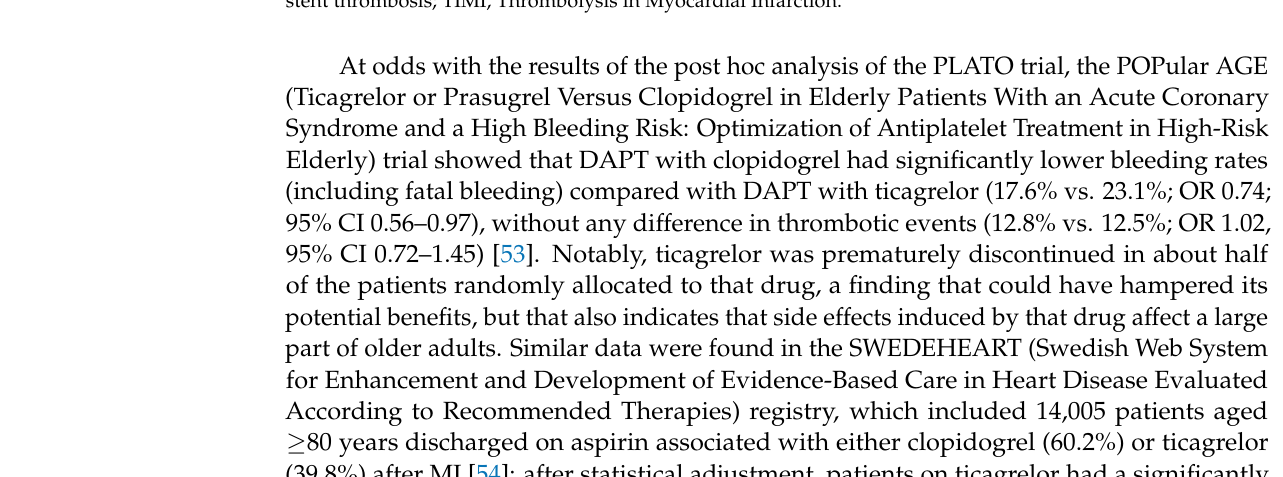
ACS patients undergoing invasive